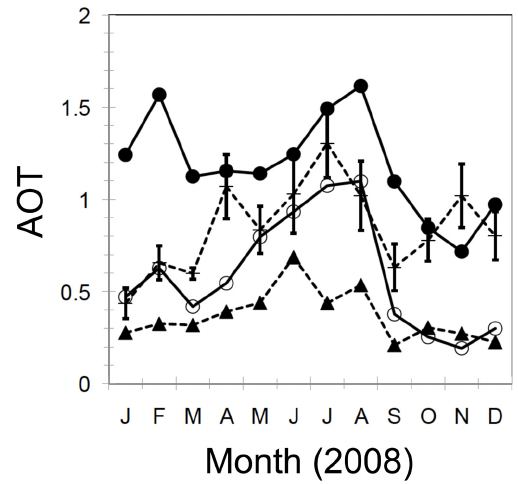
Fig. 3. As in Fig. 1, but for AOT except for MODIS/Terra observa- tions (dashed line with black